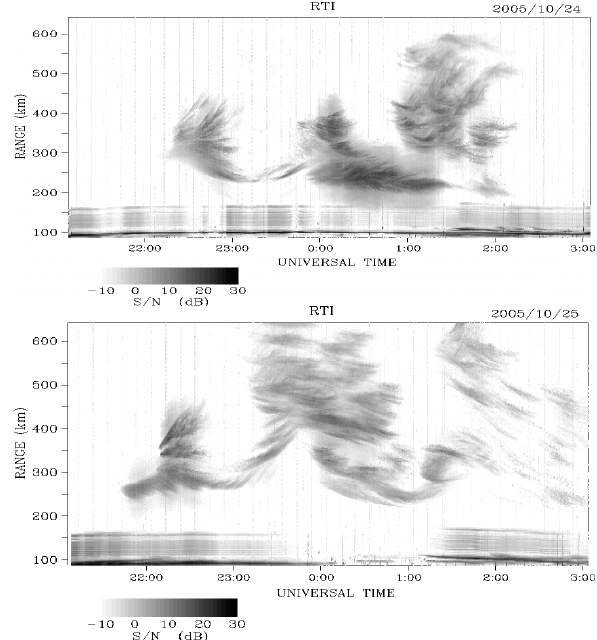
Fig. 5. Spread F and plasma bubbles observed in the zenith on 24/25 (top) and 25/26 October 2005 (bottom) by the VHF radar at S˜ao Luis during the SpreadFEx measurement campaign. The plume occurrence on both days follows closely the uplifted bottomside F- layer seen in Fig. 8 below and exhibits a similar